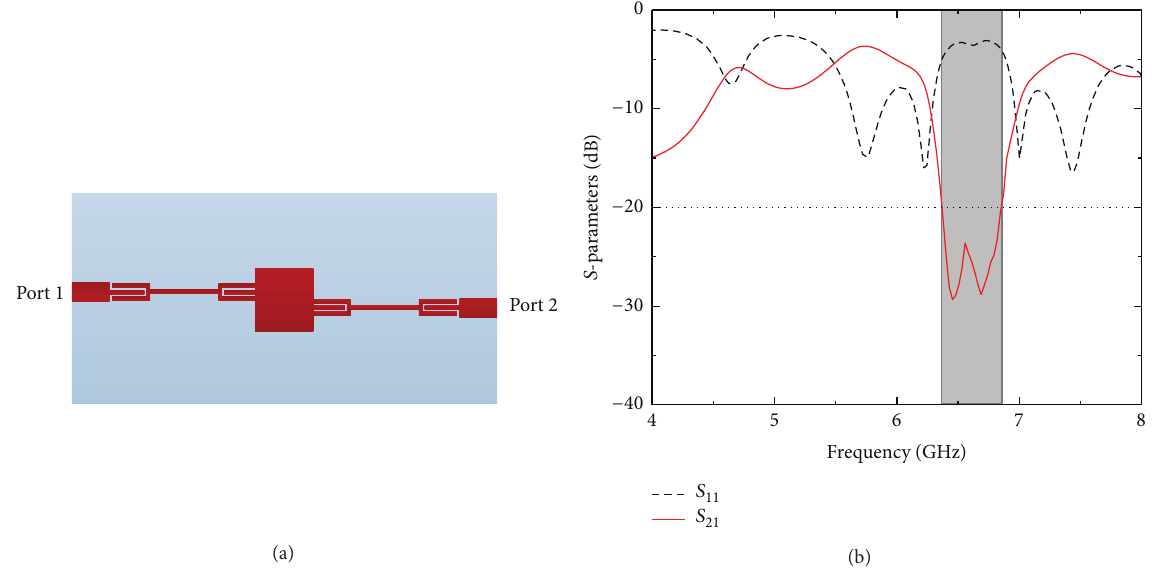
Figure 15: (a) Bandstop filter model and (b) simulated 𝑆 -parameters of the